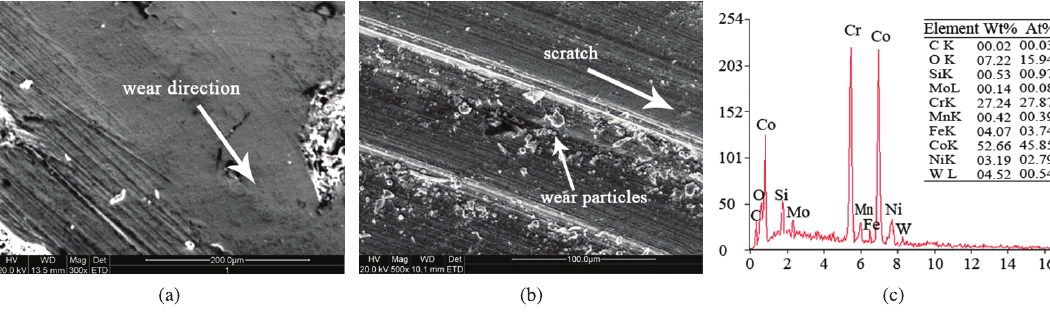
Figure 7. Worn surface morphology and EDS analysis under different speed conditions at 10 N. (a) Worn surface morphology at 0.06 m/s, 10 N; (b) Worn surface morphology at 0.18 m/s, 10 N; (c) EDS analysis of the worn surface at 0.18 m/s, 10 N.